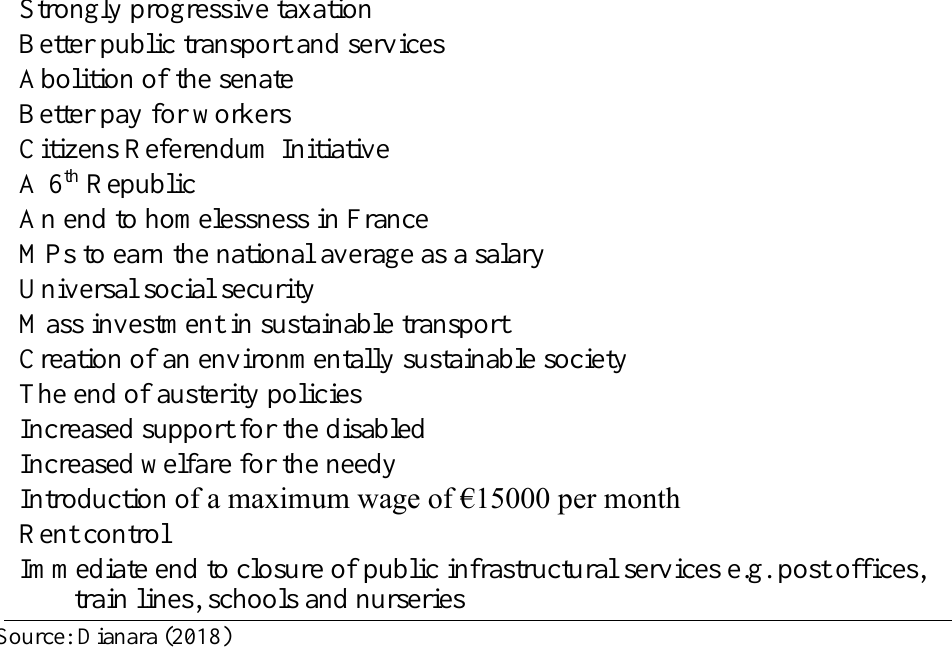
Table 1. Key Gilets Jaunes demands for social and economic justice Strongly progressive taxation Better public transport and services Abolition of the senate Better pay for workers Citizens Referendum Initiative A 6 th Republic An end to homelessness in France MPs to earn the national average as a salary Universal social security Mass investment in sustainable transport Creation of an environmentally sustainable society The end of austerity policies Increased support for the disabled Increased welfare for the needy Introduction of a maximum wage of €15000 per month Rent